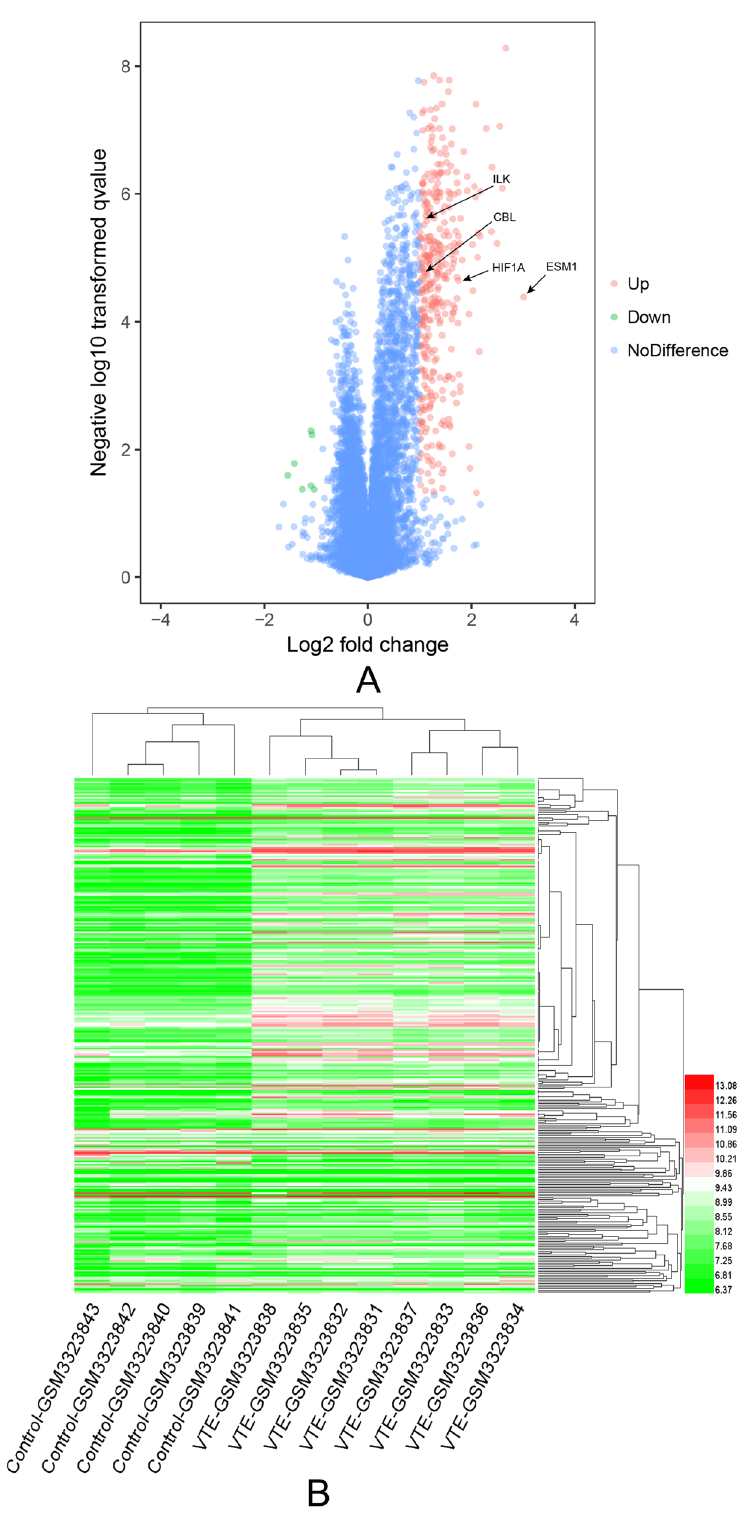
Figure 2. Identification of DEGs and hierarchical clustering analysis. ( A ) The volcano plot of GSE118259, with red nodes indicating up-regulated genes with logFC > 1 and p value < 0.05, green nodes down-regulated genes with logFC < -1 and p value < 0.05, and blue nodes similarly expressed genes. ( B ) Heat map of DEGs. The bottom horizontal axis shows sample names and the top horizontal axis shows the sample clusters. Each row represents a single gene and the right vertical axis represents DEG clusters. Colors closer to red indicate high gene expression levels and those closer to green indicate low gene expression levels. Differentially expressed genes, DEGs, Fold change, FC. Created with R soft 3.5.3 (https:// mirro rs. tuna. tsing hua. edu. cn/